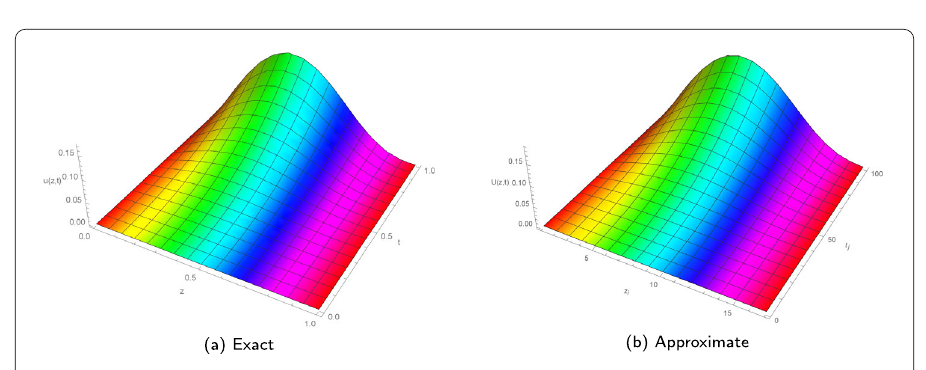
Figure 7 Exact and approximate solutions for Example 2 when N = 16, α = 0.8, t = 1, (cid:3) t = 0.001, and 0 ≤ z ≤